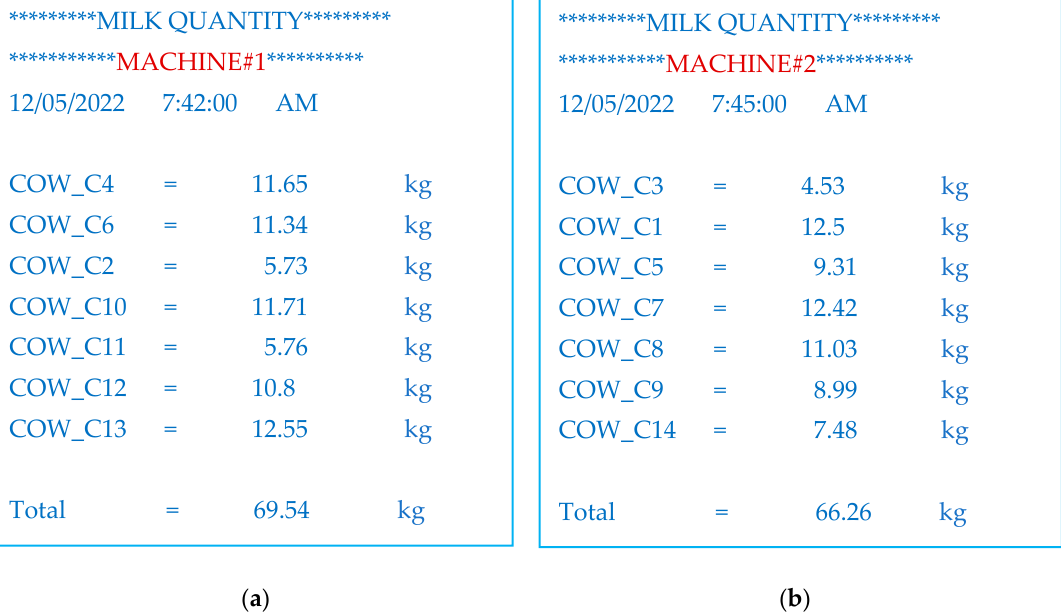
Figure 12. Data recording on SD memory card: ( a ) Control unit#1 and ( b ) Control unit#2.